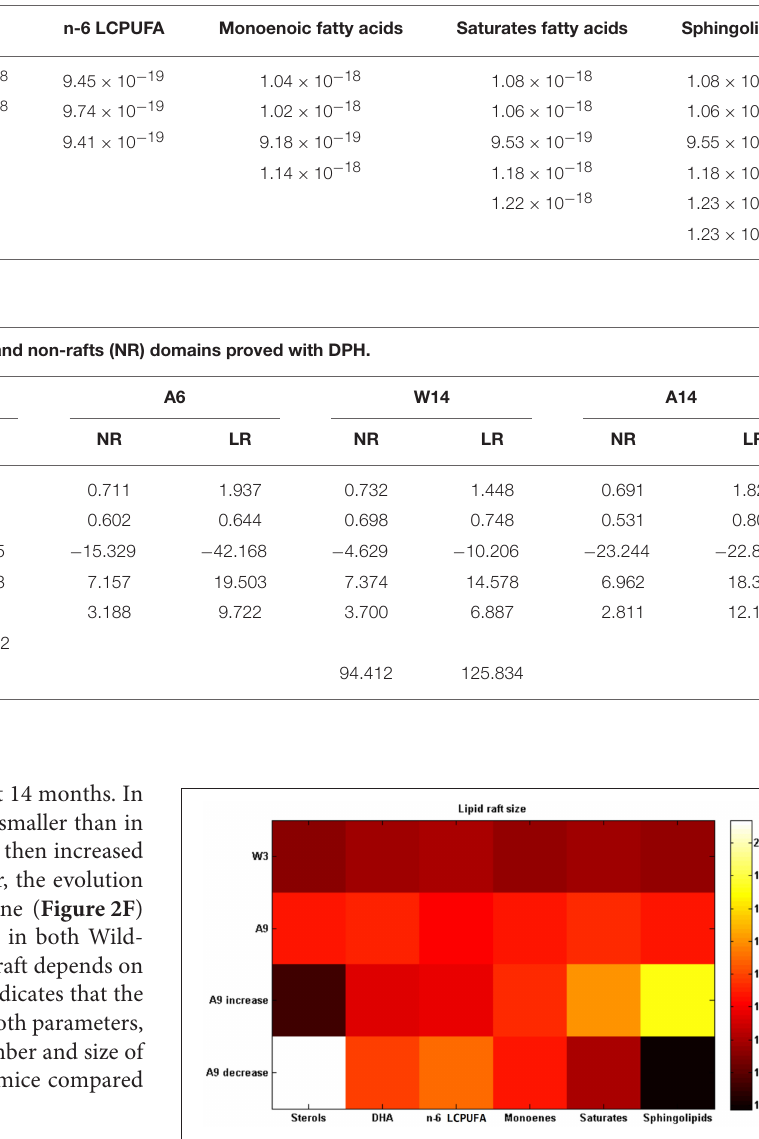
FIGURE 4 | Changing lipid composition. Lipid raft size after increasing each lipid proportion by 50% in the 9 months APP/PS1 transgenic mice (third row) or decreasing it (fourth row). First row displays the data from 3 months old Wild-type mice and second row the data from 9 months old APP/PS1 transgenic mice (data on Table S7). All the experimental data in this figure were taken from Fabelo et al.